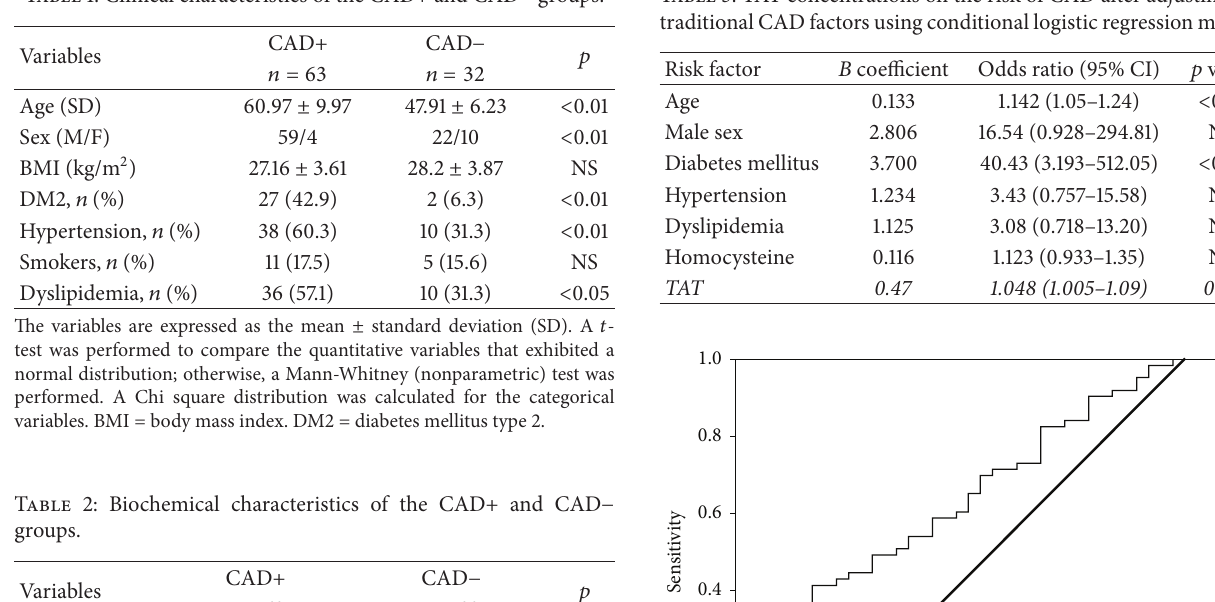
Table 1: Clinical characteristics of the CAD+ and CAD − groups.